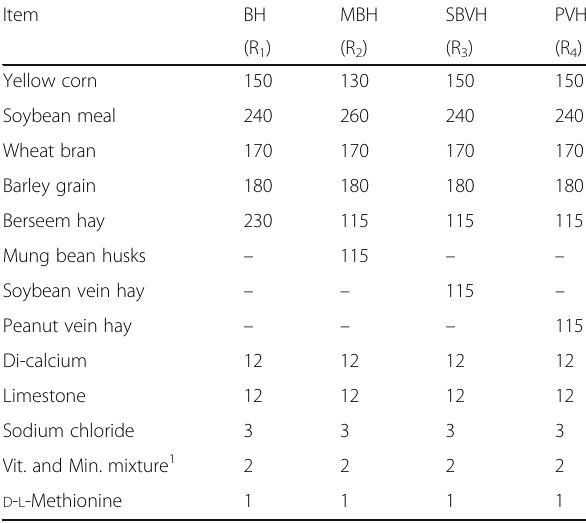
Table 1 Composition of the experimental